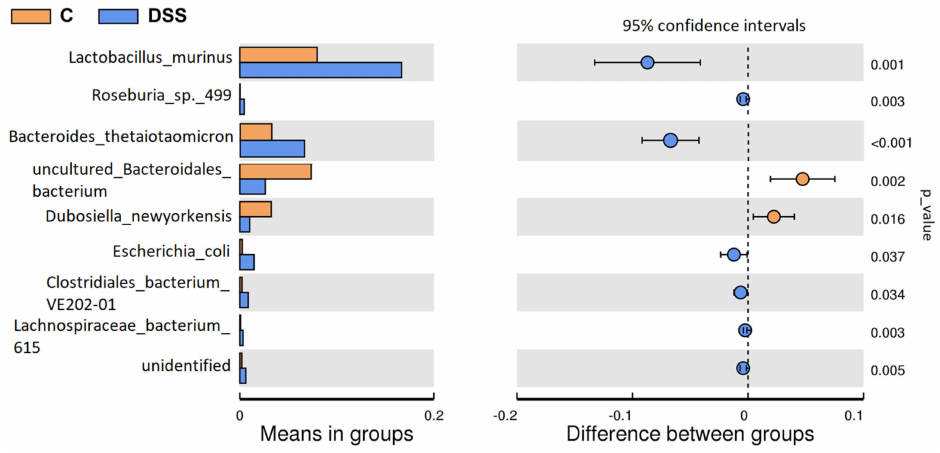
Figure 11. Between-group T-test analysis of faecal samples. DSS, induced colitis; C, healthy control. Representative Krona diagrams in Figure 12 show abundance of different families within Firmicutes in faeces (Figure 12A,C) and caeca (Figure 12B,D). Lactobacillaceae were more abundantly represented in the faeces of both experimental groups, while Lach- nospiraceae and Ruminococcaceae dominated in the caecum. Faecal and caecal samples from the DSS group (Figure 13A) were compared using the linear discriminant analysis (LDA) effect size (LEfSe) algorithm, which shows caecal enrichment in the taxa of Clostridi- ales. The order Lactobacillales was the more abundant taxa in both groups (Figure 12). Caeca in the control group (Figure 13B) were predominantly occupied with genera Alistipes and Faecalibacterium in comparison to faeces, where the dominant genera were Alloprevotella together with Bacteroides .